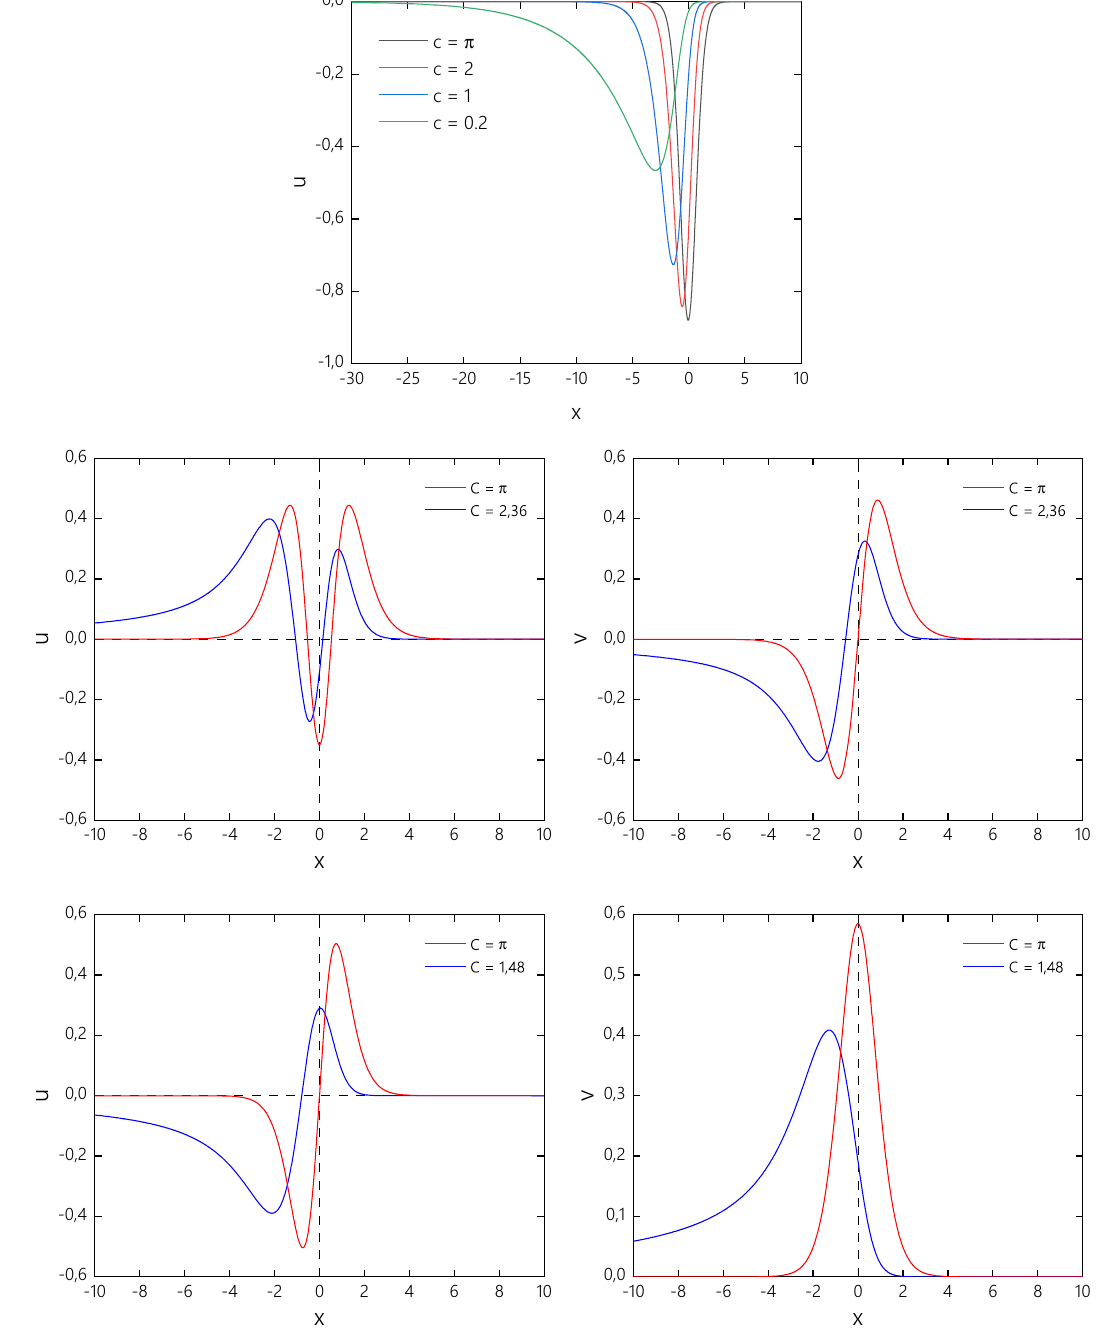
Fig. 3 Components of the localized fermionic modes of the types A 0 (upper plot), A 1 (middle row) and B 1 (bottom row) are plotted as functions of the coordinate x for m = 0, g = 1 and some set of values of the Yukawa coupling parameter